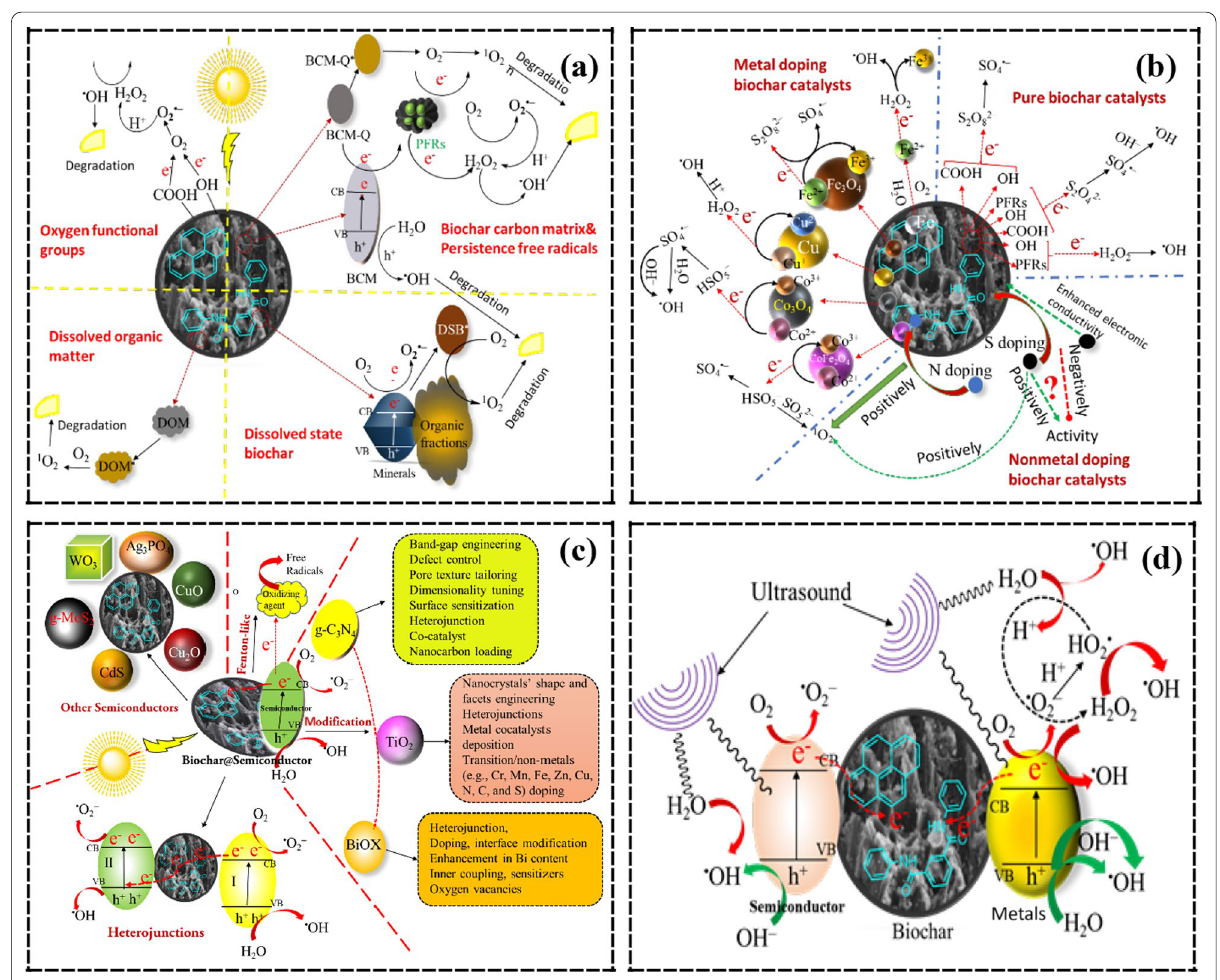
Fig. 3 A proposed mechanism for pollutant degradation by the pure biochar at light radiation ( a ); biochar-based catalysts by Fenton-like reaction ( b ); biochar-based catalysts by photocatalysis reaction ( c ); biochar-based catalysts by sonocatalysis reaction ( d